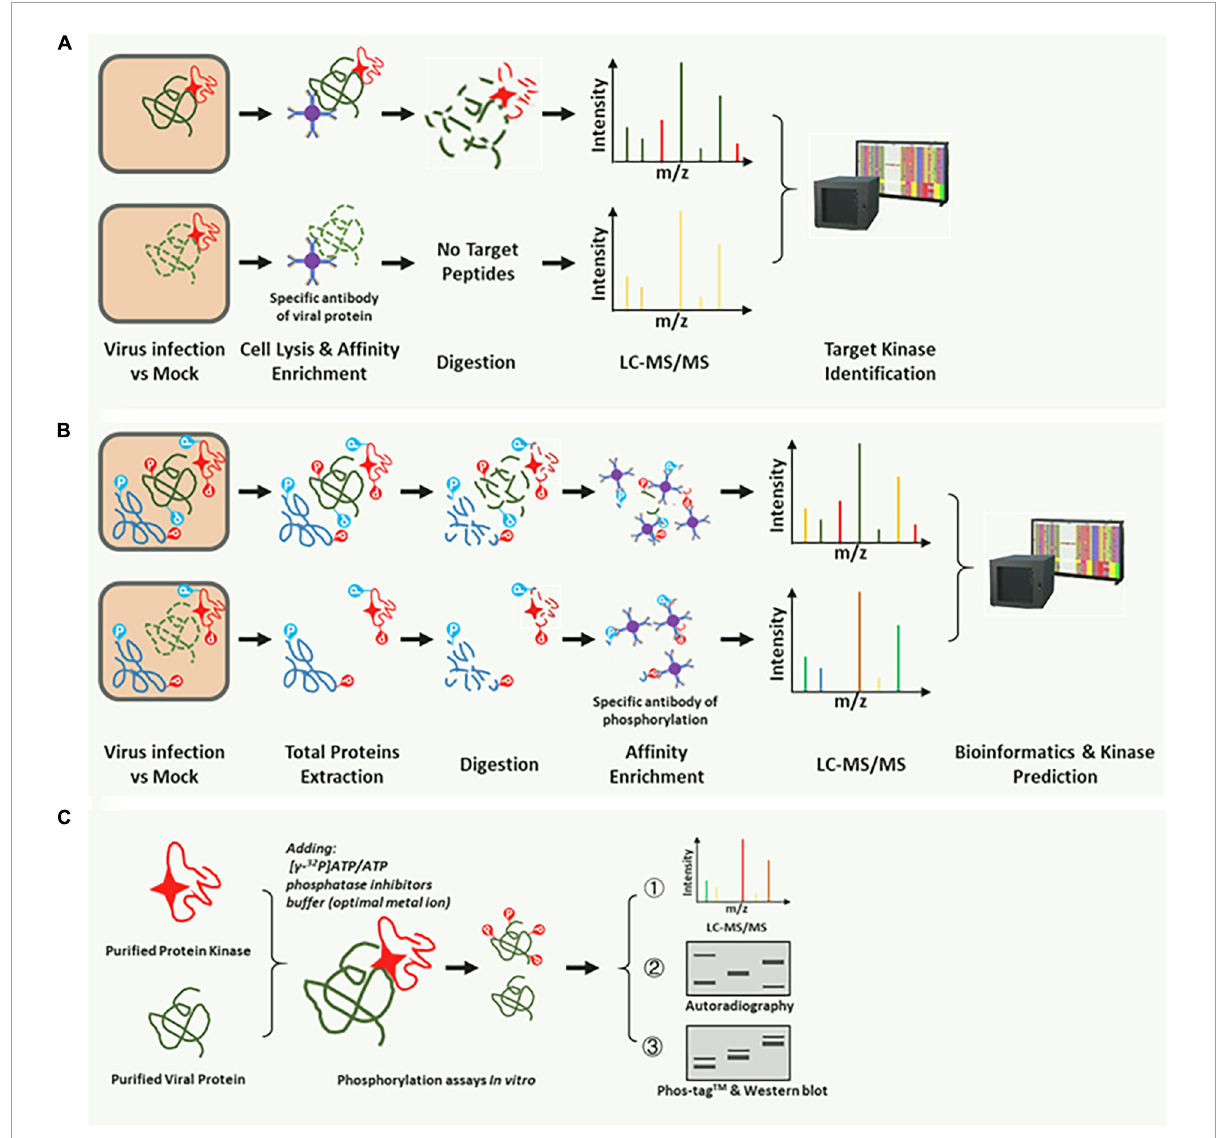
FIGURE2 Common methods for identification of the corresponding kinase of the target substrate. (A) The target substrate interacts with and is phosphorylated by a specific kinase. A substrate-specific antibody was used for co-immunoprecipitation (Co-IP) of the corresponding kinase. The kinase could be identified by the LC-MS, and BLASTP was performed on the NCBI or the species-specific database. (B) High-throughput phosphoproteomic analysis based on the LC-MS/MS. The p-motifs could be determined using phosphor-peptides and interrogation of the corresponding database. Then, the kinase type could be identified using the already phosphorylation mode in the database. Using the third method (C), a specific kinase can be confirmed. (C) In vitro phosphorylation reaction system for further validation of the target